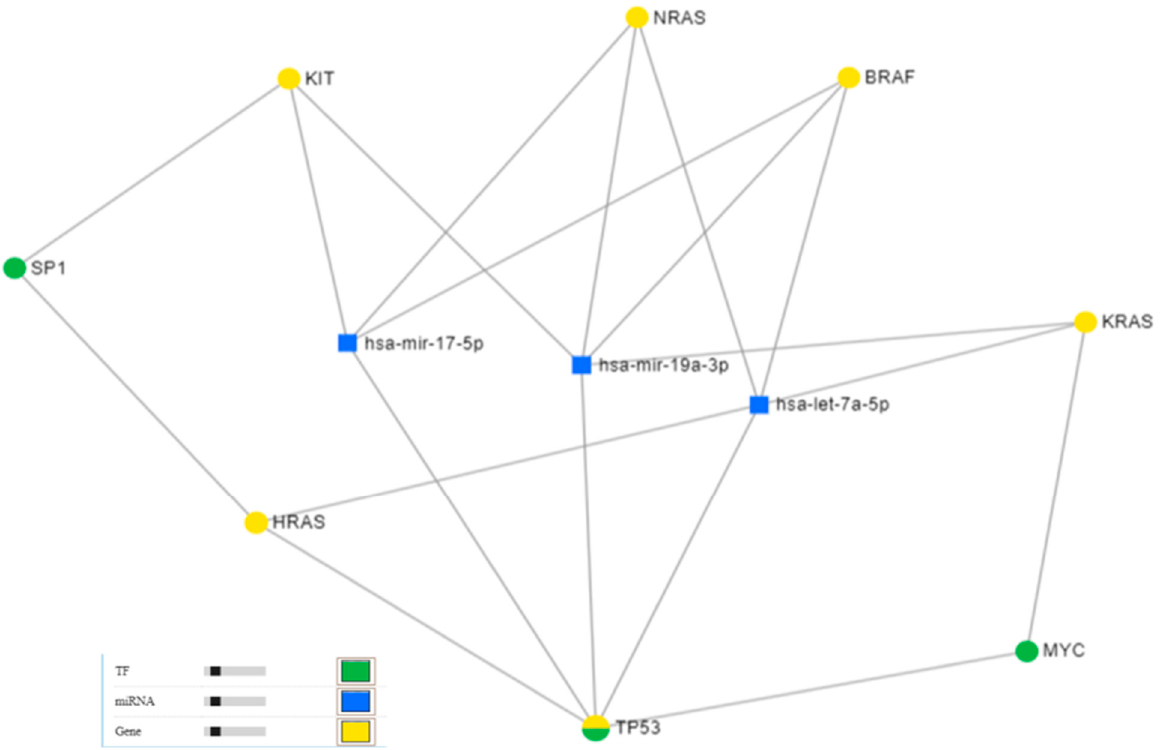
Figure 3. The gene–miRNA interaction in melanoma as revealed using miRNET.